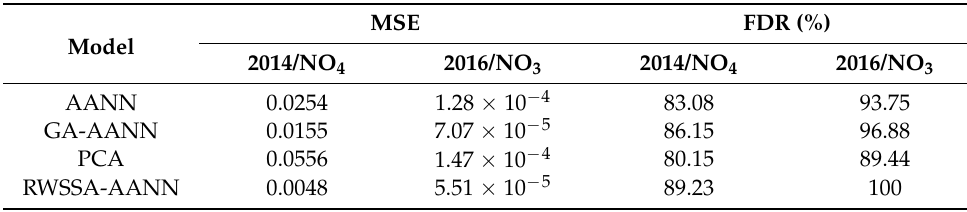
Figure 13. Faulty wind speed and reconstruction wind speed of No. 3 wind turbine in 2016.